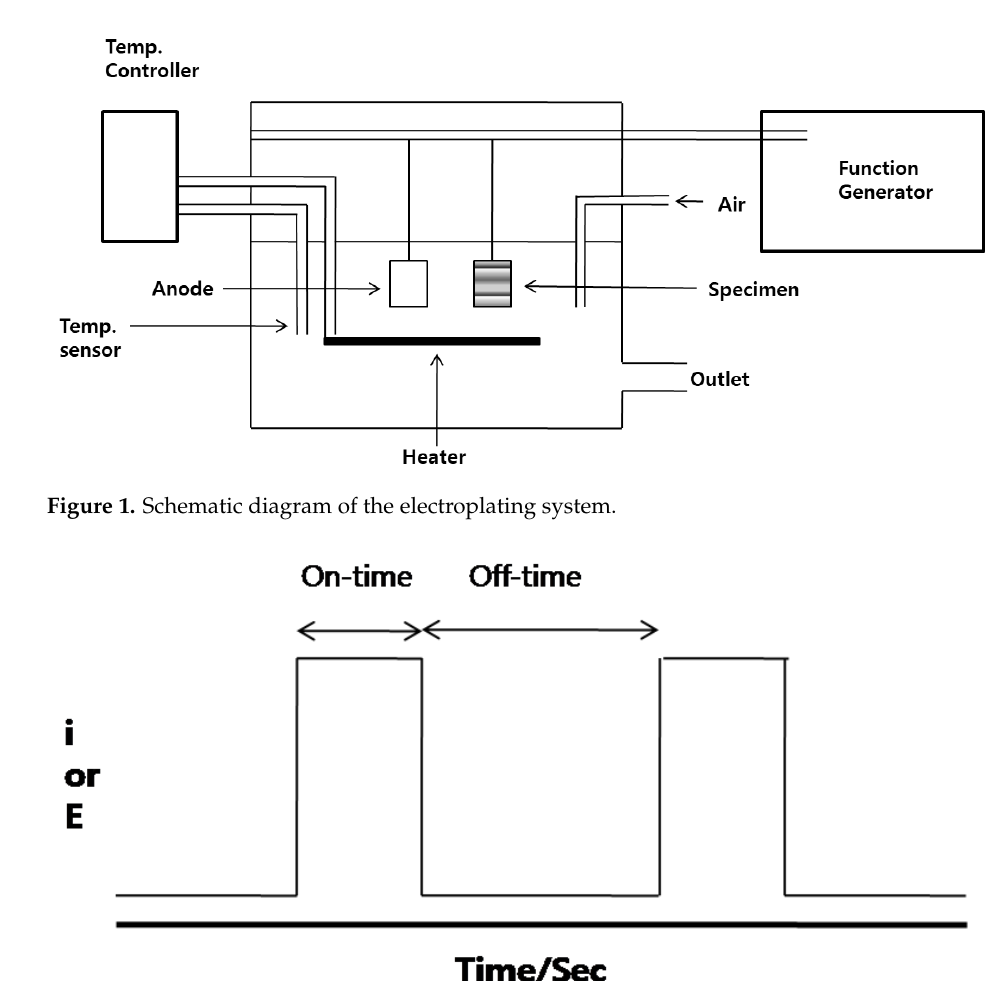
Figure 2. A waveform of pulse electroplating.